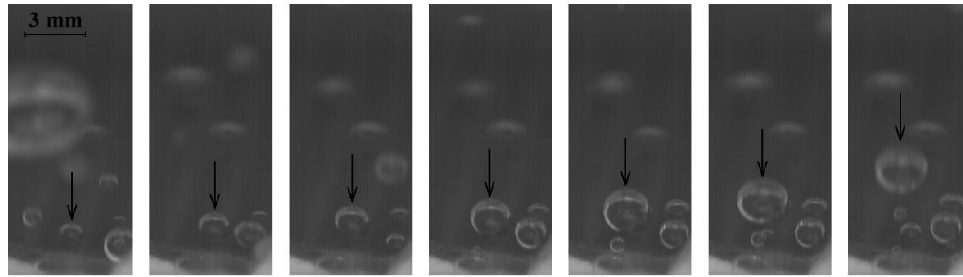
Figure 18. Vapor bubble development sequence (time interval between each photo: 0.04 s) (the arrow marks the same bubble in each photo).